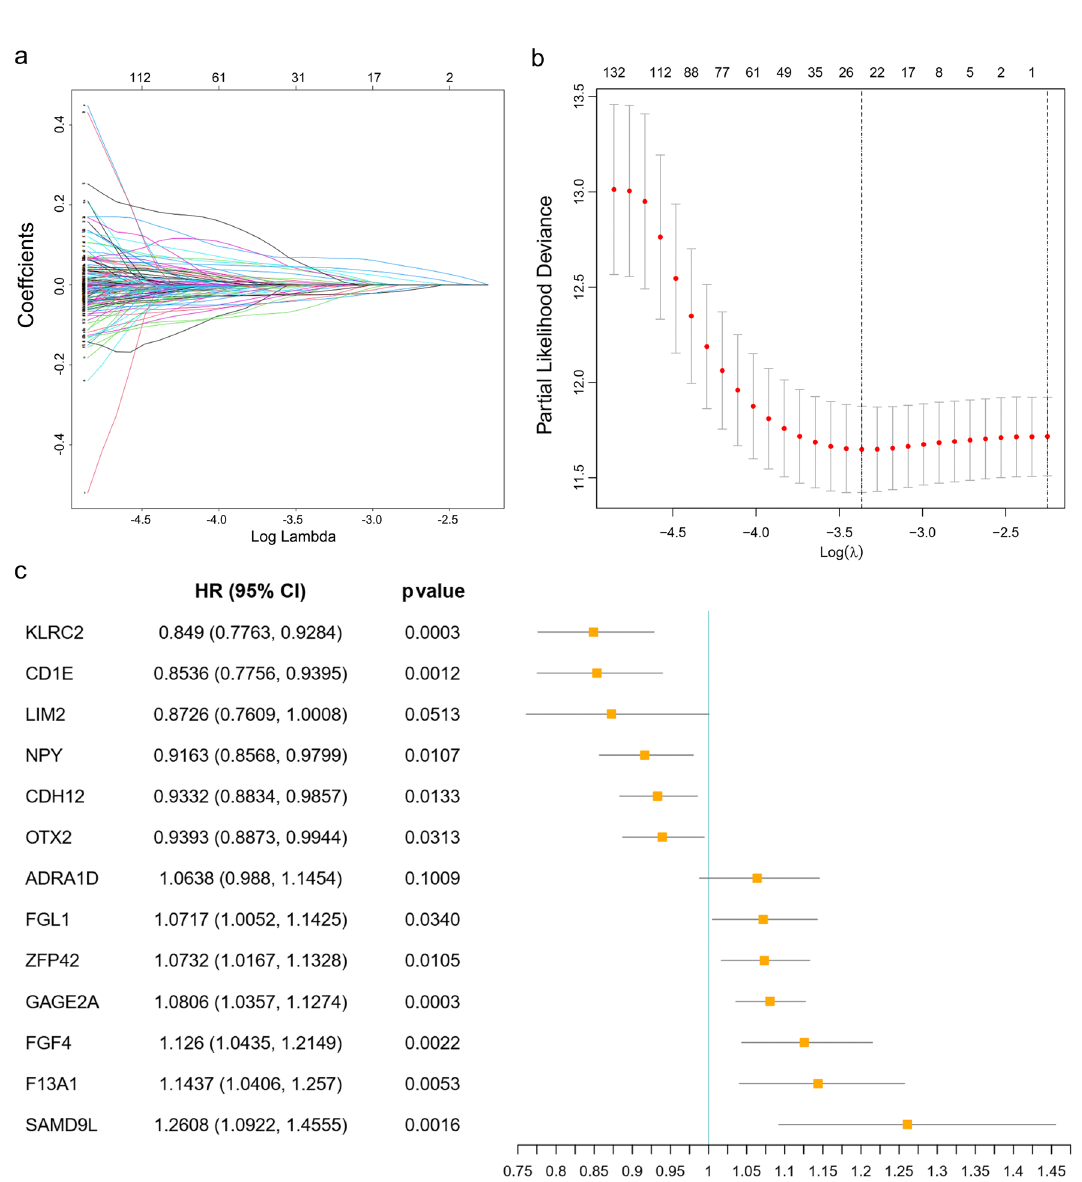
Figure 5. Identification of 13 prognostic genes in The Cancer Genome Atlas cohort. ( a , b ) Partial likelihood deviance coefficient profiles and Least absolute shrinkage and selection operator cox analysis of the hub genes. After 10 rounds of cross-validation, the optimal value of turning parameter is determined as 23. ( c ) Hazard ratios (HR) forest plot of the 13-gene signature constructed by the multivariate cox analysis. HR > 1 indicates that the gene is a risk factor. HR < 1 indicates that the gene is a protection